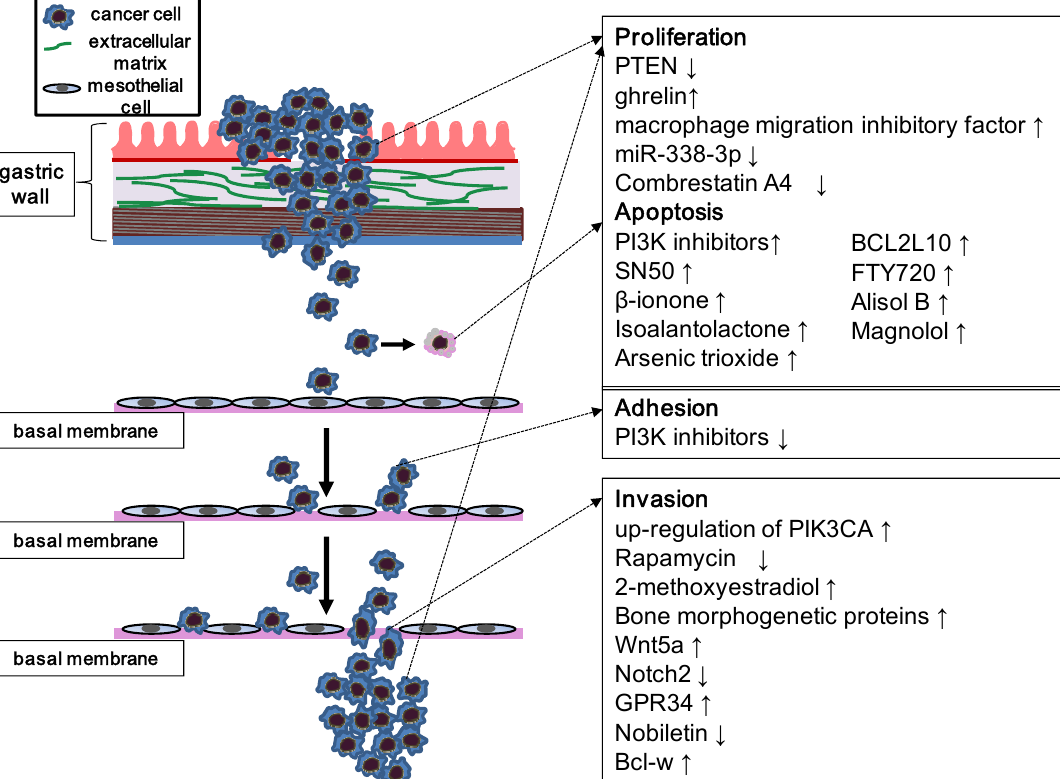
Figure 2. Schematic representation of the PI3K/Akt/mTOR pathway involved in carcinoma metastasis. The figure focuses on the biological process of peritoneal metastasis, which is one of the most common metastatic types of gastric carcinoma, although these principles apply to most patterns of metastases. The PI3K/Akt/mTOR pathway is involved in each step of metastasis; thus, numerous inhibitors and agents can affect these processes by modulation of PI3K signaling. Stimulatory events are indicated by upward arrows and inhibitory events are indicated by downward